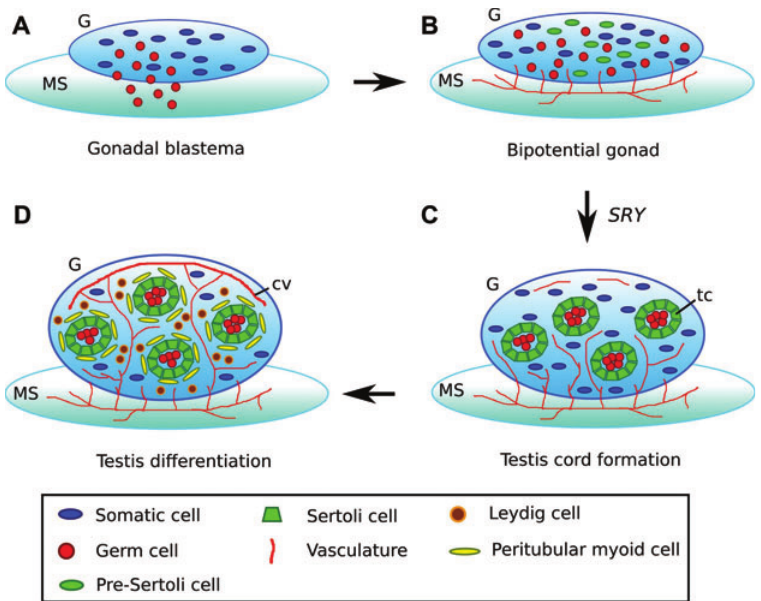
Figure 1 An overview of early SC and testis